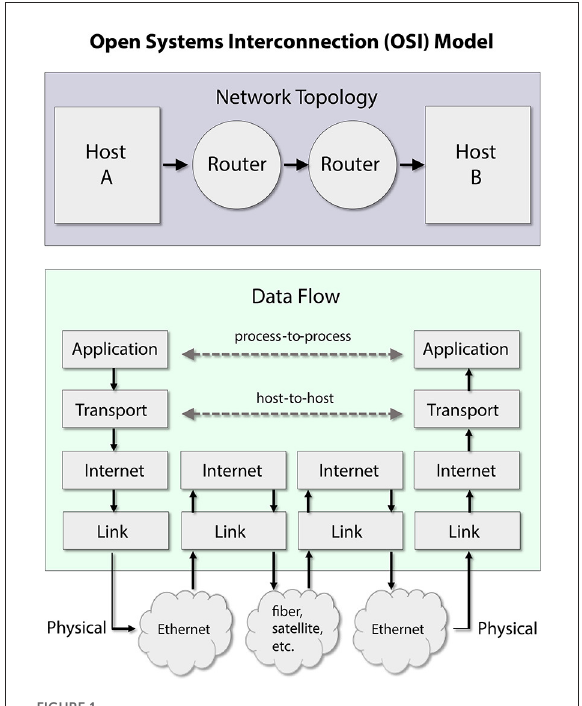
FIGURE1 A simplified conceptual design of the internet protocol stack, based on the open systems interconnection (OSI) model. Network topology determines the passage of messages across the network between hosts. The flow of data across the network is organized into conceptual layers. A message originates in the application layer and descends by way of the transport layer and internet layer to a physical layer link (e.g., wire or fiber-optic cable). At intermediary routers, messages ascend only to the internet layer, which plans out the message’s forward route. The message then returns to the physical layer for onward travel. This diagram omits the presentation layer and the session layer, which are less relevant for our purposes, and can be seen as part of the application